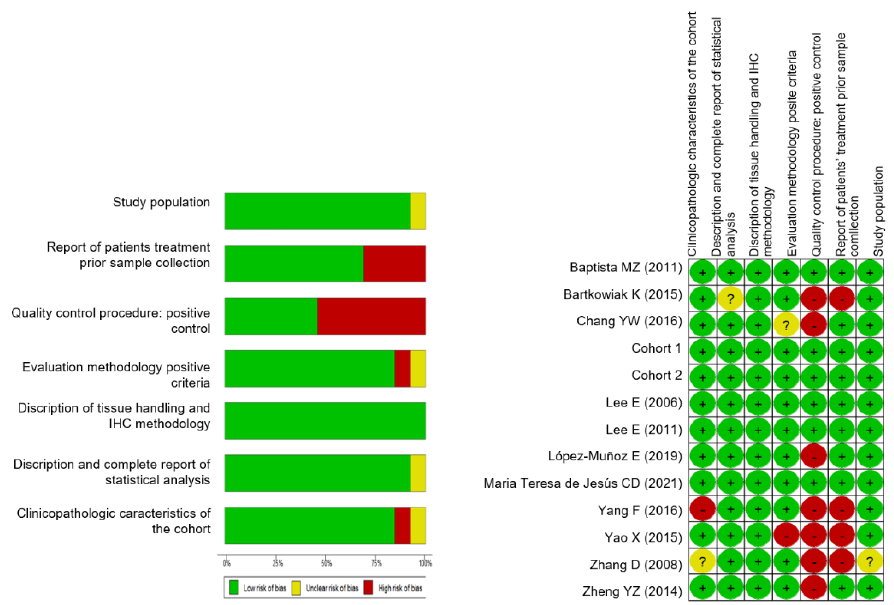
Figure 4. Risk of bias assessment per criteria presented as percentages across all included studies and risk of bias in individual studies: Baptista, M.Z. (2011) [11], Bartkowiak, K. (2015) [42], Chang, Y.W. (2016) [43], Cohort 1, Cohort 2, Lee, E. (2006) [41], Lee, E. (2011) [48], López-Muñoz, E. (2019) [47], Maria Teresa de Jesús, C. D. (2021) [46], Yang, F. (2016) [44], Yao, X. (2015) [5], Zhang, D. (2008) [45], Zheng, Y.Z. (2014) [10]. + (green circles): low risk; ? (unclear, yellow circles): unclear risk; - (red circles): high risk.